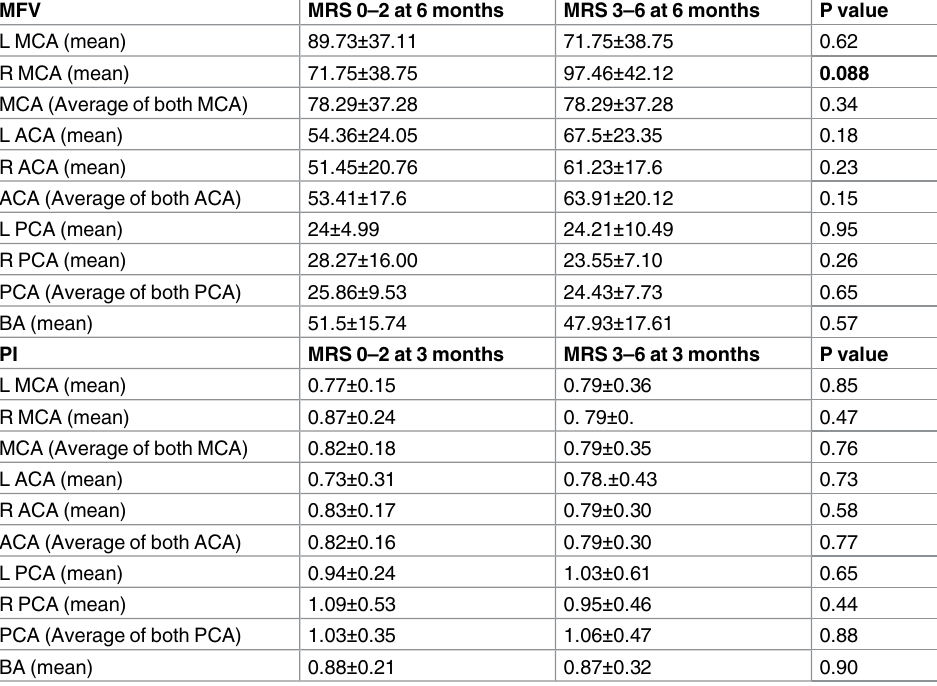
Table 5. Mean flow velocities and pulsatility index correlation with Modified Rankin scale (MRS) at 6 months. ACA-anterior cerebral artery; BA- basilar artery; MCA-middle cerebral artery; PCA- posterior cere- bral